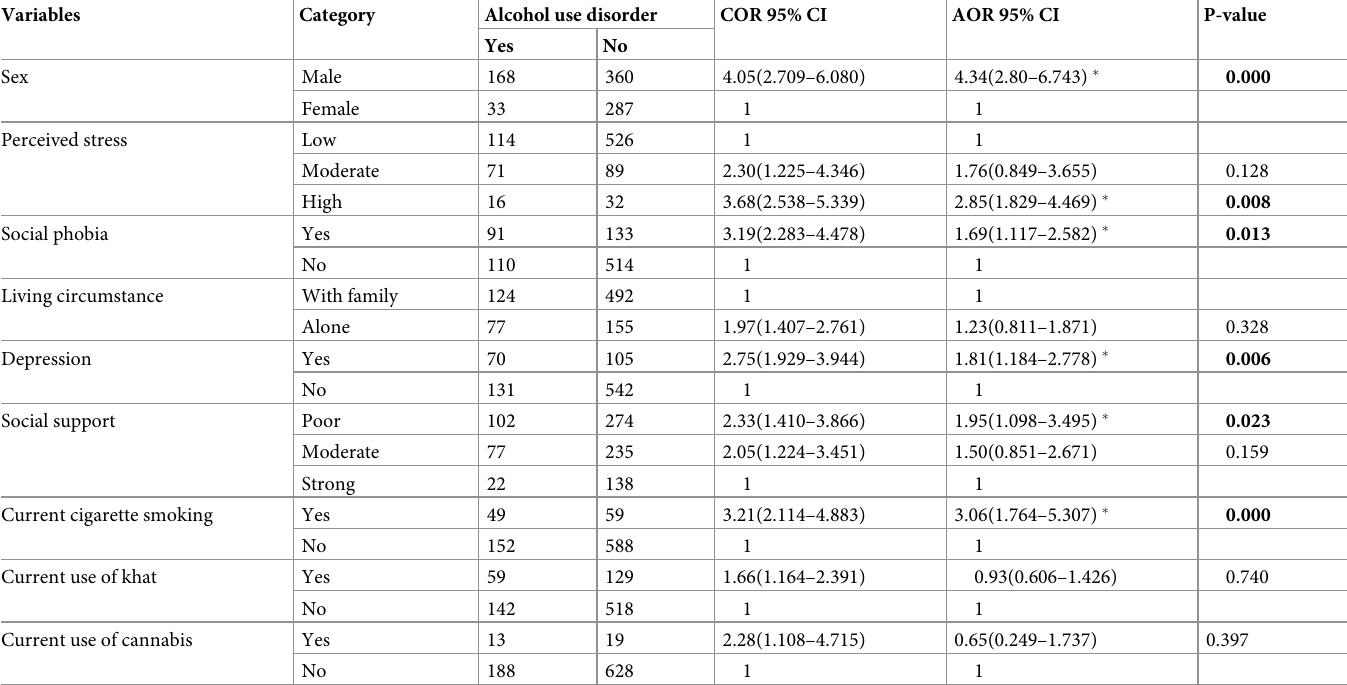
Table 3. Factors associated with Alcohol use disorder among residents of south Gondar zone, northwest Ethiopia, 2020 (N = 848).